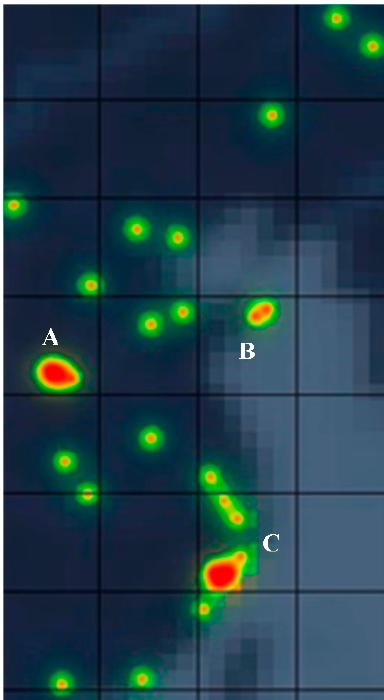
Figure 8. Part of the heat map.